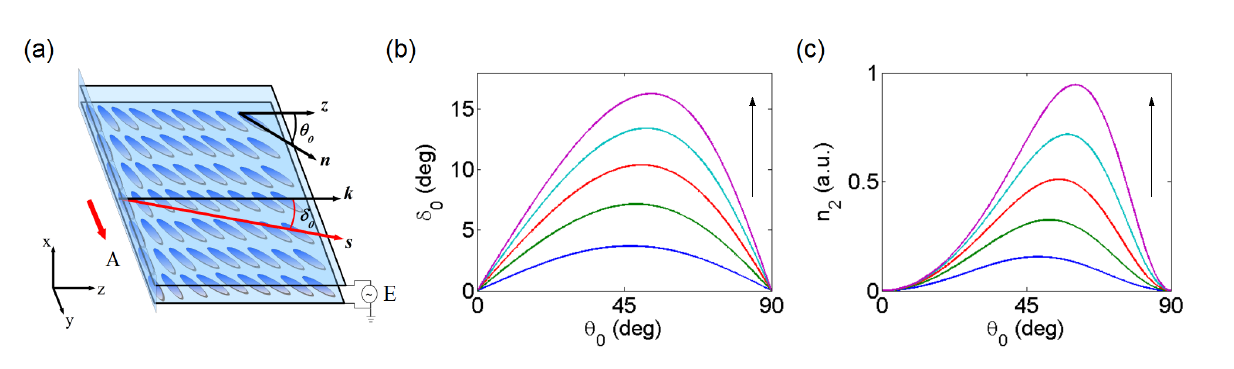
Figure 2. ( a ) Sketch of a bias-free planar NLC cell. The angle θ = δ ( θ ) between the Poynting vector s and the wavevector k // ˆ z ; ( b ) Walk-off walk-off δ 0 0 and ( c ) nonlinear (Kerr-like) coefficient versus θ n ? = 1 . 5 (the arrows indicate increasing n jj from 1.6 to 2 in steps of